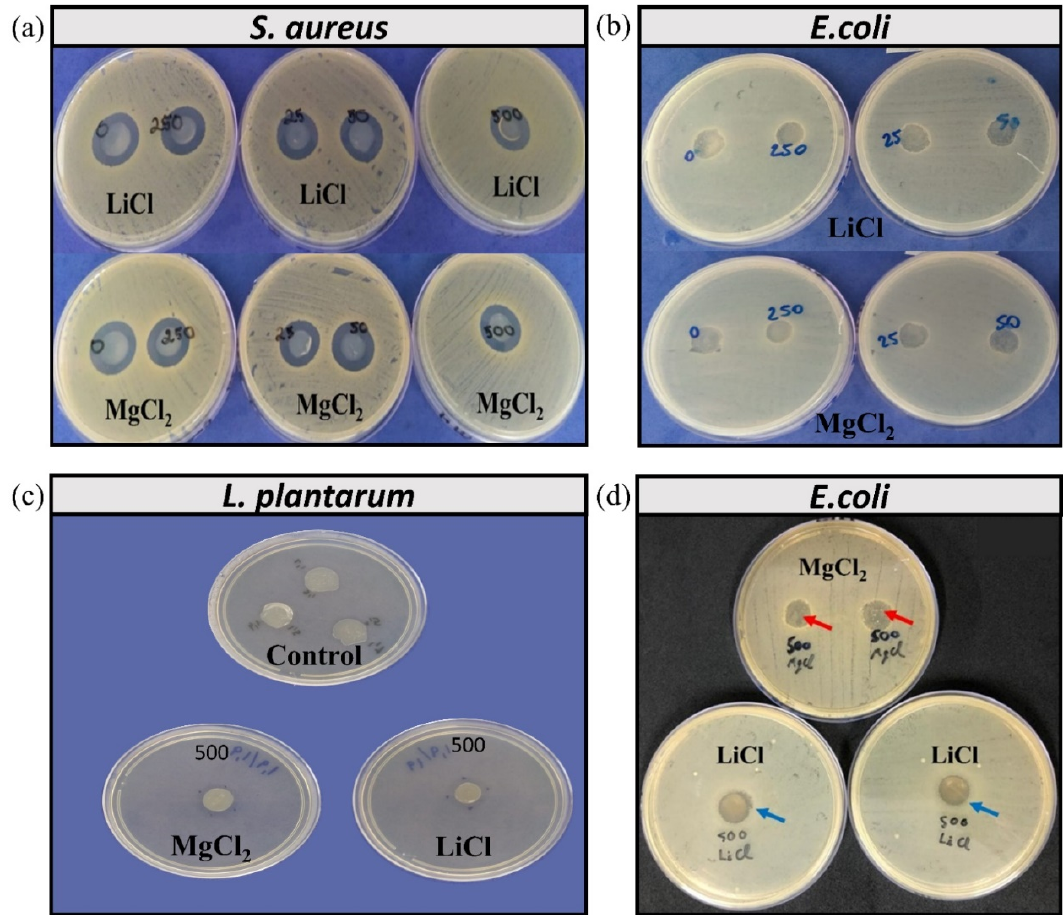
Figure 5. Photographs of the antibacterial activity of MC-based films with 10% of Nisin-Z with IS of 0, 25, 50, 250, and 500 mM due to LiCl or MgCl 2 addition, tested by direct contact against S. aureus ( a ) = tested at 37 °C/24 h. Photographs of the antibacterial activity of MC-based films with 10% Nisin-Z with IS of 0, 25, 50, and 250 mM ( b ) and 500 mM ( d ) due to LiCl or MgCl 2 addition, tested by direct contact against E. coli . Susceptibility of L. plantarum against the active films with IS of 0 (control) and 500 mM due to LiCl and MgCl 2 addition at 37 °C/48 h, under anaerobic conditions ( c ).